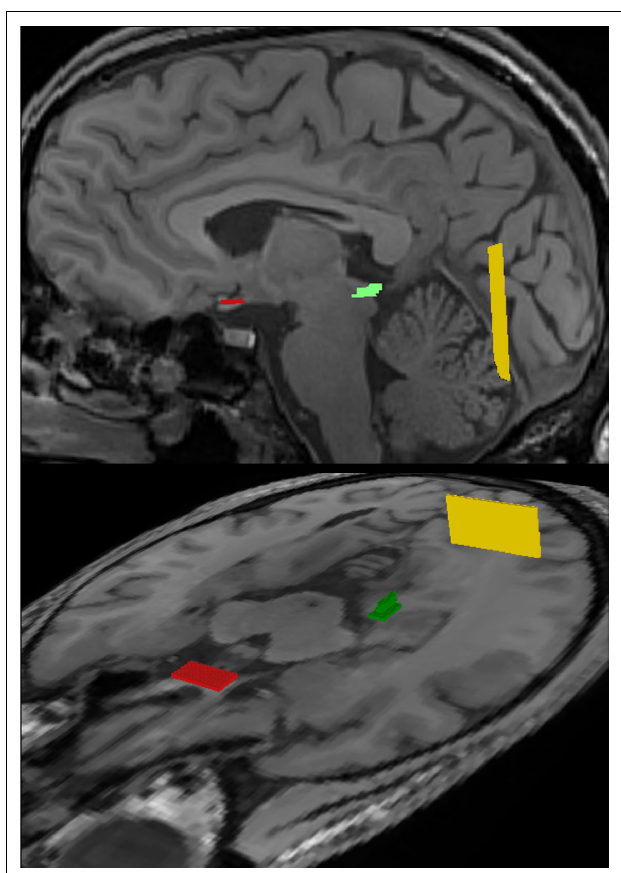
FIGURE 3 | Regions-of-interest (ROI) chosen for fi ber tractography of the visual pathway in complementary views. The optic nerve and optic tract were delineated by combining a start ROI in the optic chiasm (red) with a target ROI in the LGN (green). Correspondingly, the optic radiation was obtained by a start ROI in the LGN (green) and a target ROI in the white matter next to primary visual areas (yellow). For further details see text.